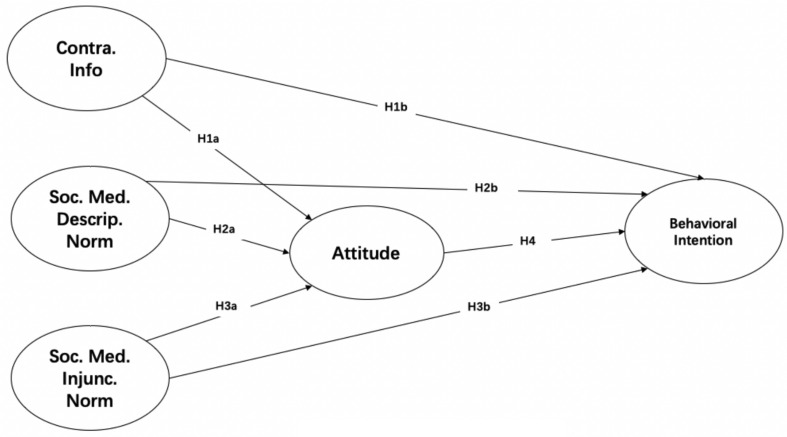
Conceptual model.